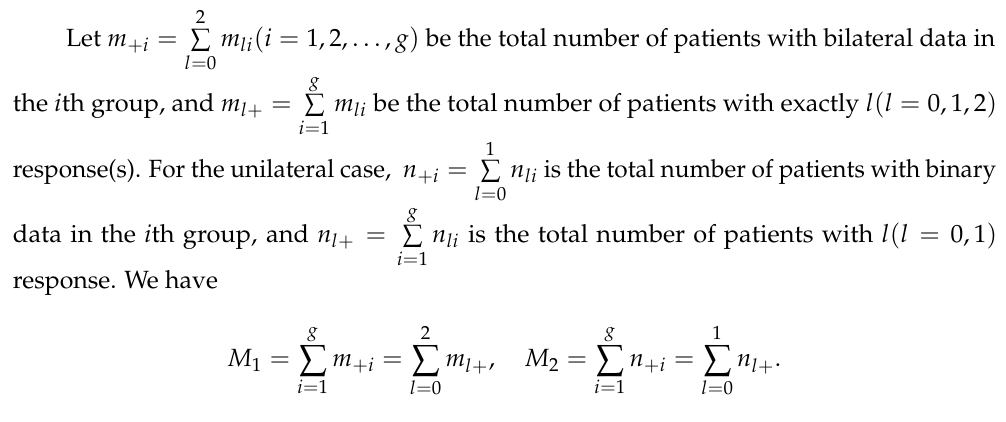
Table 2. The unilateral and bilateral data in g groups. Group ( i ) Response ( l ) Total 1 2 ... g 0 m 01 m 02 ... m 0 g m 0 + 1 m 11 m 12 ... m 1 g m 1 + 2 m 21 m 22 ... m 2 g m 2 + Total m + 1 m + 2 ... m + g M 1 0 n 01 n 02 ... n 0 g n 0 + 1 n 11 n 12 ... n 1 g n 1 + Total n + 1 n + 2 ... n + g M 2 2 ∑ m li ( i = 1, 2, . . . , g ) be the total number of patients with bilateral data in Let m + i = l = 0 g